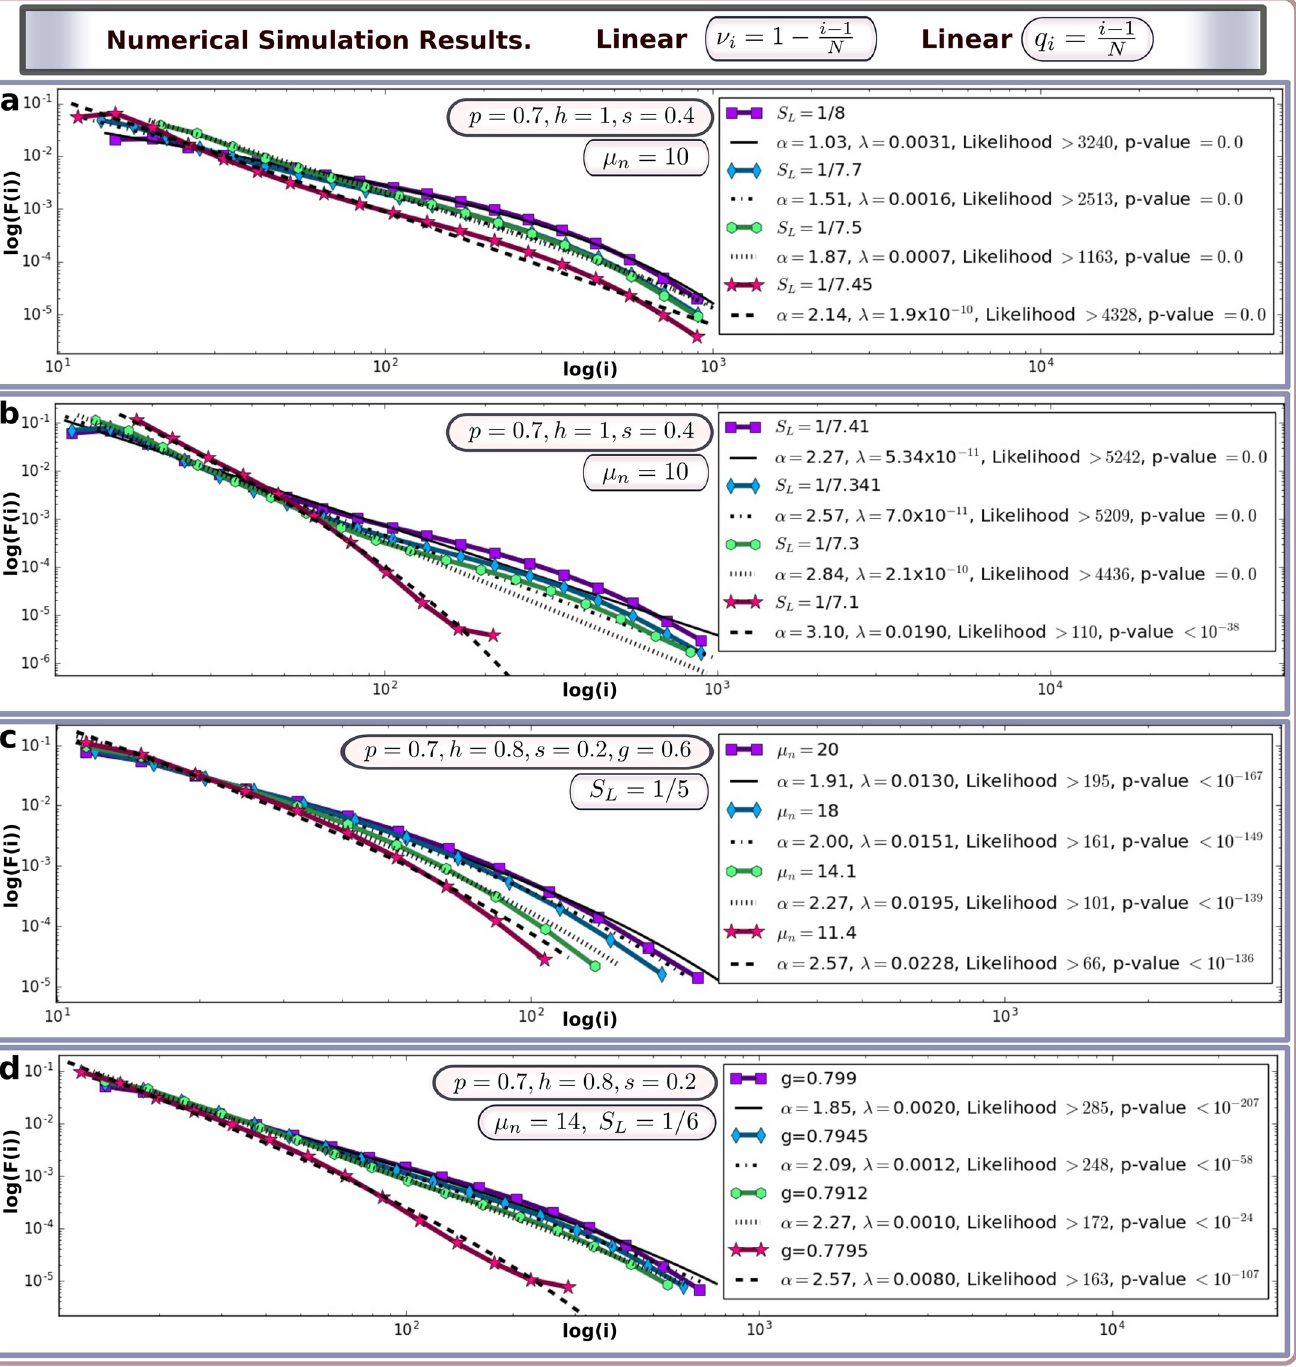
and ν . In all graphs, colored i i = 1/8 to S = 1/7.1 increases the power L L = 1/6 and μ L n